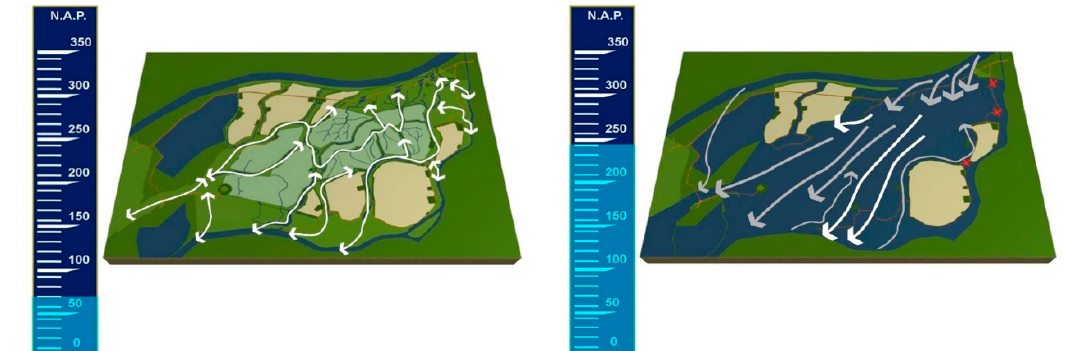
Figure 3. Water Level Diagrams. Left-hand diagram shows the regular flood when water reaches 40–70 cm. Right-hand diagram shows water level with 240 cm of flooding, calculated to occur once every 100 years. Image courtesy of Annika Hesselink and Rijkswaterstaat.